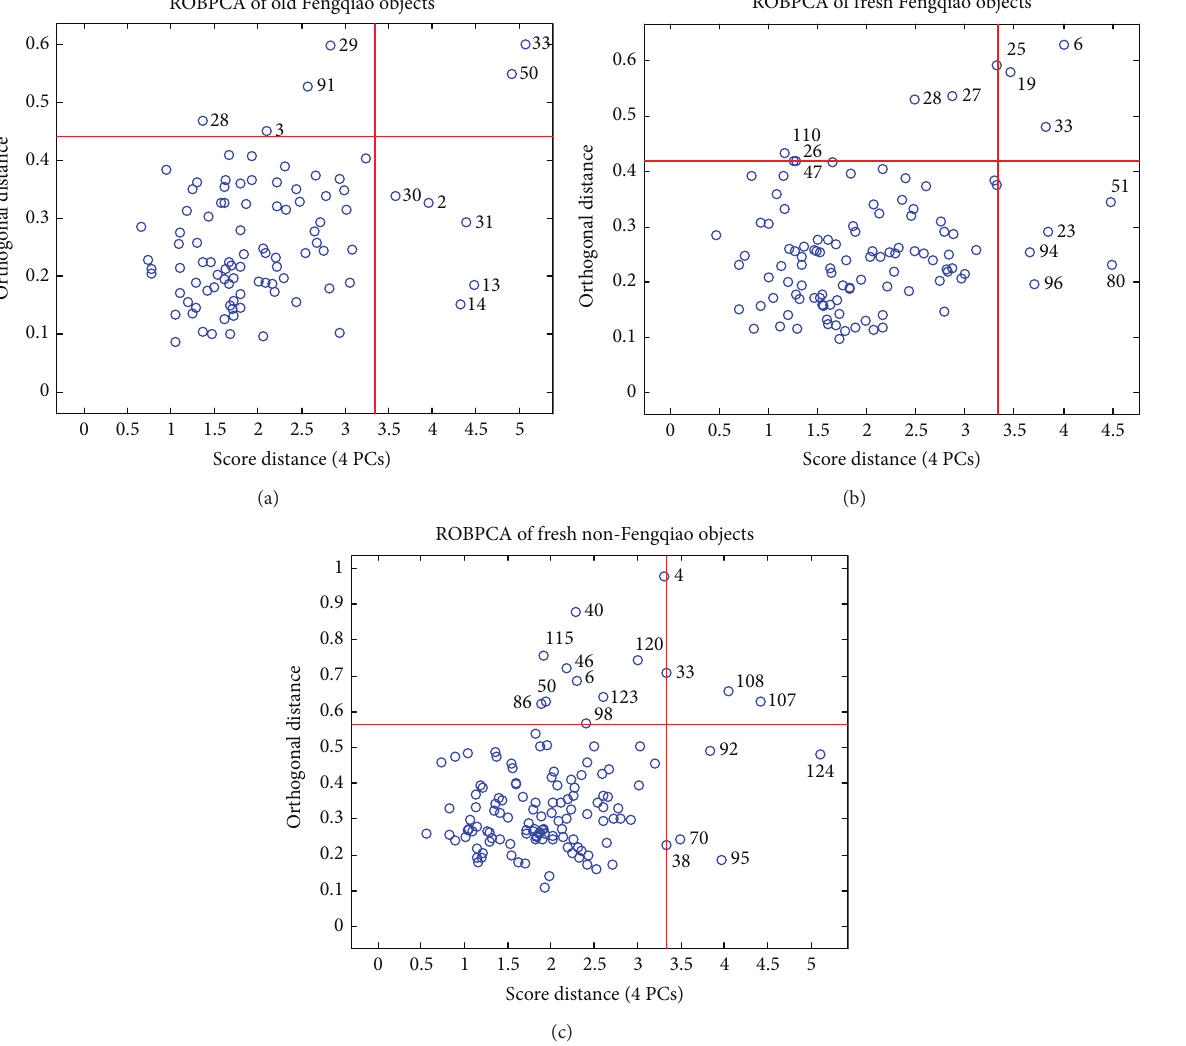
groups of seed kernels. For classification data of age and geo- graphical origins, the first three principal components